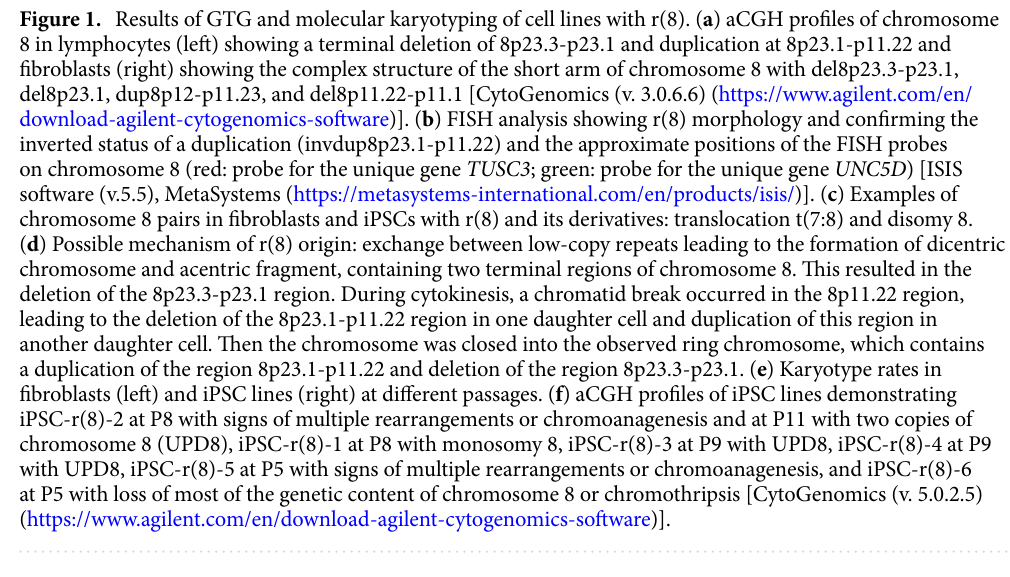
Figure 1. Results of GTG and molecular karyotyping of cell lines with r(8). ( a ) aCGH profiles of chromosome 8 in lymphocytes (left) showing a terminal deletion of 8p23.3-p23.1 and duplication at 8p23.1-p11.22 and fibroblasts (right) showing the complex structure of the short arm of chromosome 8 with del8p23.3-p23.1, del8p23.1, dup8p12-p11.23, and del8p11.22-p11.1 [CytoGenomics (v. 3.0.6.6) (https ://www.agile nt.com/en/ downl oad-agile nt-cytog enomi cs-softw are)]. ( b ) FISH analysis showing r(8) morphology and confirming the inverted status of a duplication (invdup8p23.1-p11.22) and the approximate positions of the FISH probes on chromosome 8 (red: probe for the unique gene TUSC3 ; green: probe for the unique gene UNC5D ) [ISIS software (v.5.5), MetaSystems (https ://metas ystem s-inter natio nal.com/en/produ cts/isis/)]. ( c ) Examples of chromosome 8 pairs in fibroblasts and iPSCs with r(8) and its derivatives: translocation t(7:8) and disomy 8. ( d ) Possible mechanism of r(8) origin: exchange between low-copy repeats leading to the formation of dicentric chromosome and acentric fragment, containing two terminal regions of chromosome 8. This resulted in the deletion of the 8p23.3-p23.1 region. During cytokinesis, a chromatid break occurred in the 8p11.22 region, leading to the deletion of the 8p23.1-p11.22 region in one daughter cell and duplication of this region in another daughter cell. Then the chromosome was closed into the observed ring chromosome, which contains